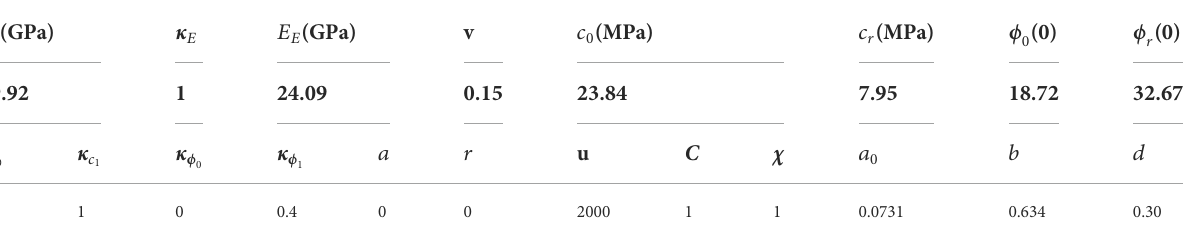
TABLE 1 Parameters for T 2y 6 marble.